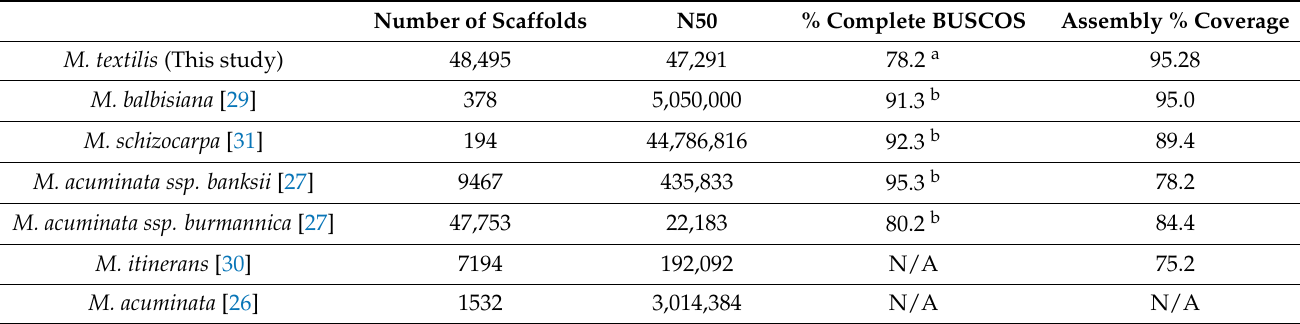
Table 1. Comparison of statistics generated in literature for the genome assembly of different Musa